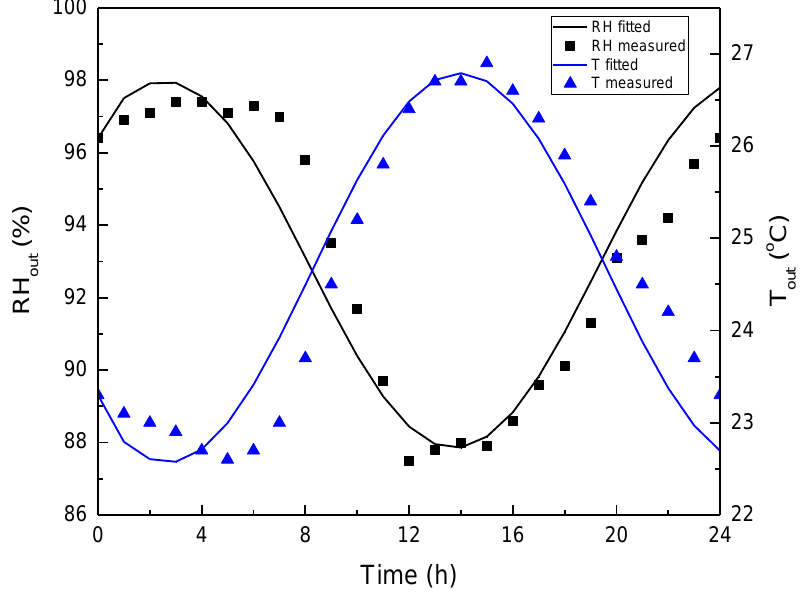
Figure 3. Outdoor air temperature ( A ) and RH ( B ) during the plum rain season in Nanjing in 2015. The diurnal outdoor meteorological parameters during the plum rain season are fitted for analysis on a typical plum rain day, as shown in Figure 4.